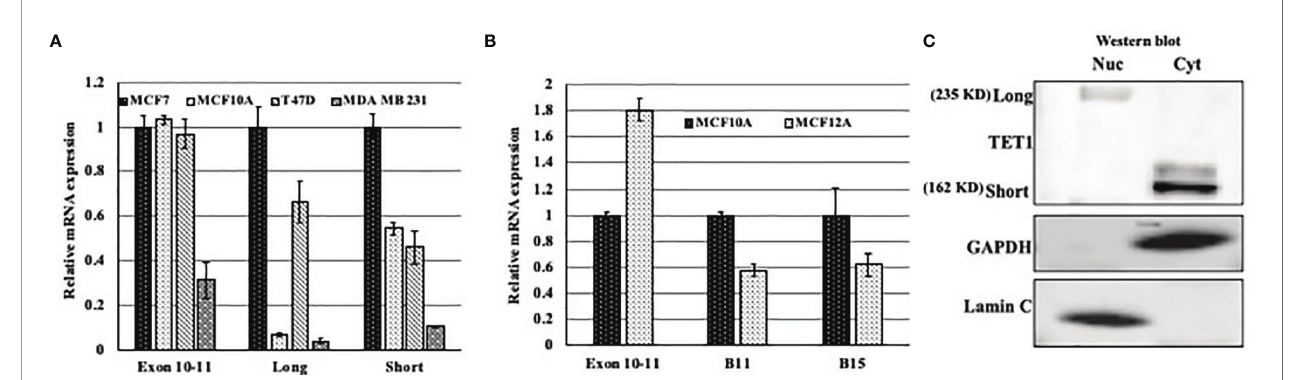
FIGURE 3 | Expression pattern of TET1 isoforms in breast cancer cell lines. (A) qPCR results of different TET1 isoforms in different cell lines. (B) qPCR results of different TET1 isoforms in immortalized non-transformed mammary gland cells representing basal (MCF10A) and luminal (MCF12A) cell-of-origin. In both experiments, primers fl anking Exons 10 and 11 were used as our reference point. The mRNA levels are shown after normalization to the level of the housekeeping gene UBC. Bars represent standard error of the mean of three replicates. (C) Western blot analysis showing the distribution of the long and short isoforms between nuclear (Nuc) and Cytoplasmic (Cyt) cell protein